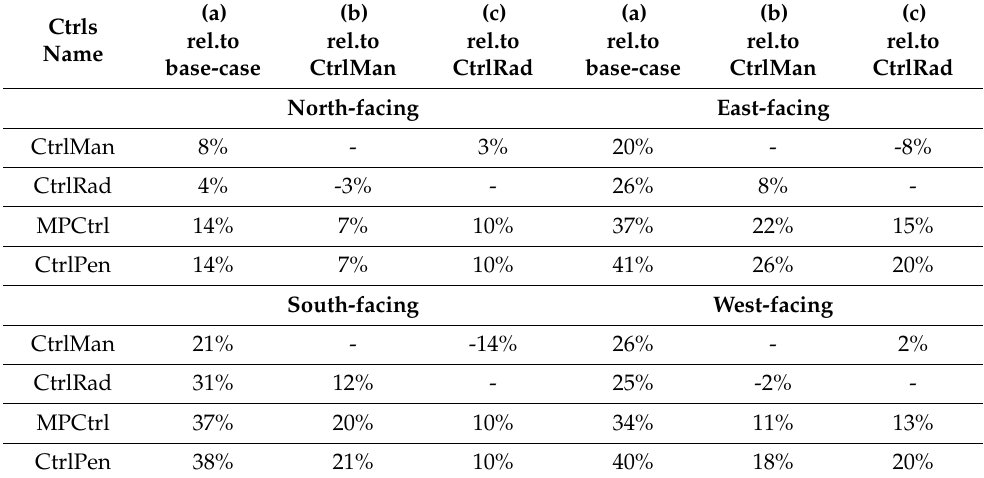
Table 6. The Relative Improvement (RI%) in terms of saving total end-use energy for different cases.